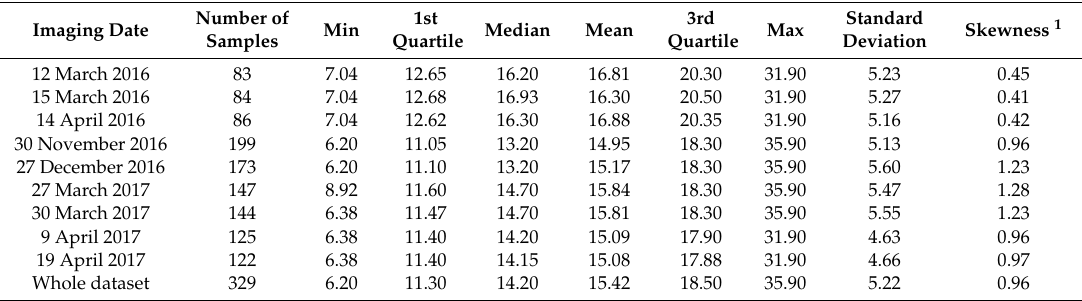
Table 3. Statistics of soil organic carbon (SOC) contents (g · kg − 1 ) according to dates (normalized di ff erence vegetation index (NDVI) ≤